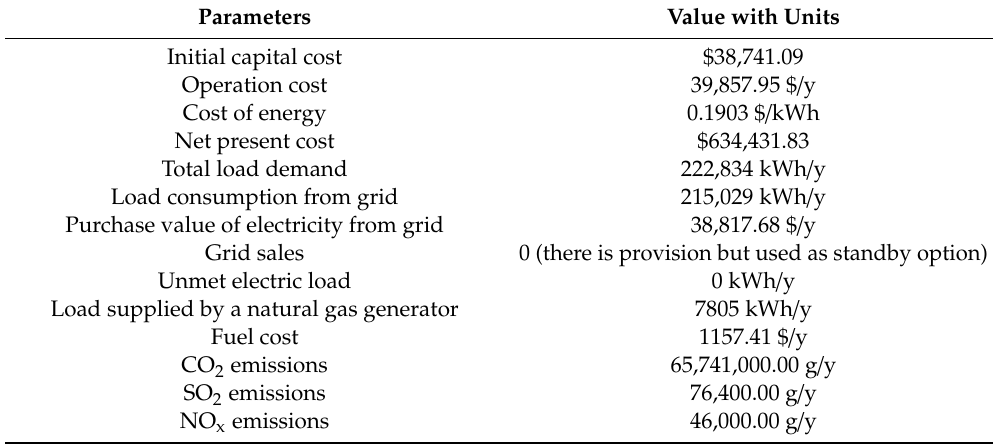
Table 7. Techno-economic and environmental indicators of EG + NGPG + BES based power supply system.